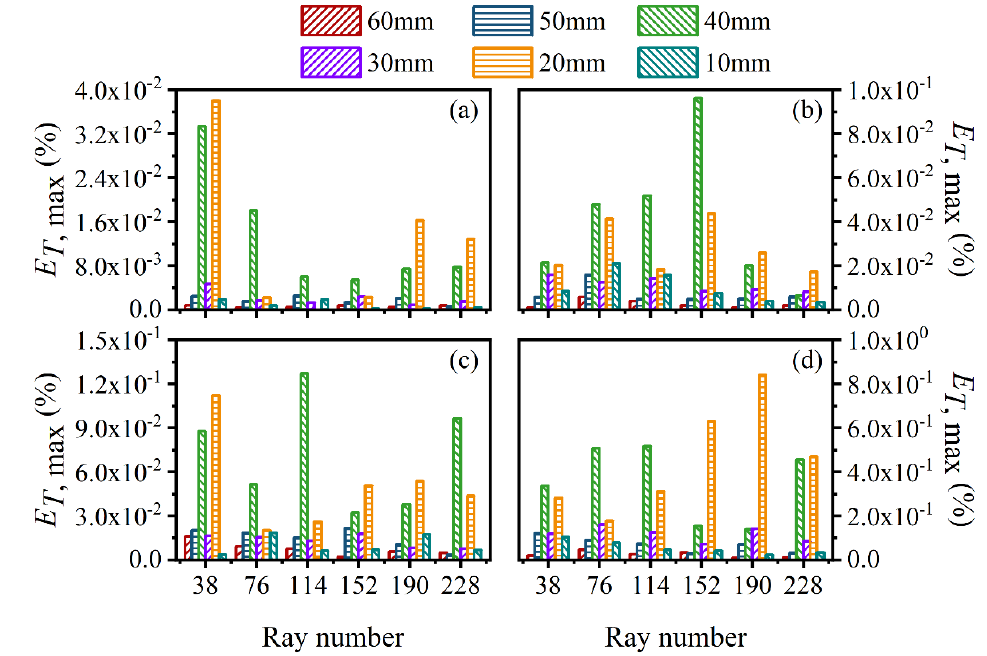
Figure 14. The maximum relative reconstruction error for the flame temperature at the main cross- sections in sooting regions. ( a ) SNR = 80 dB; ( b ) SNR = 65 dB; ( c ) SNR = 60 dB; ( d ) SNR = 46 dB.